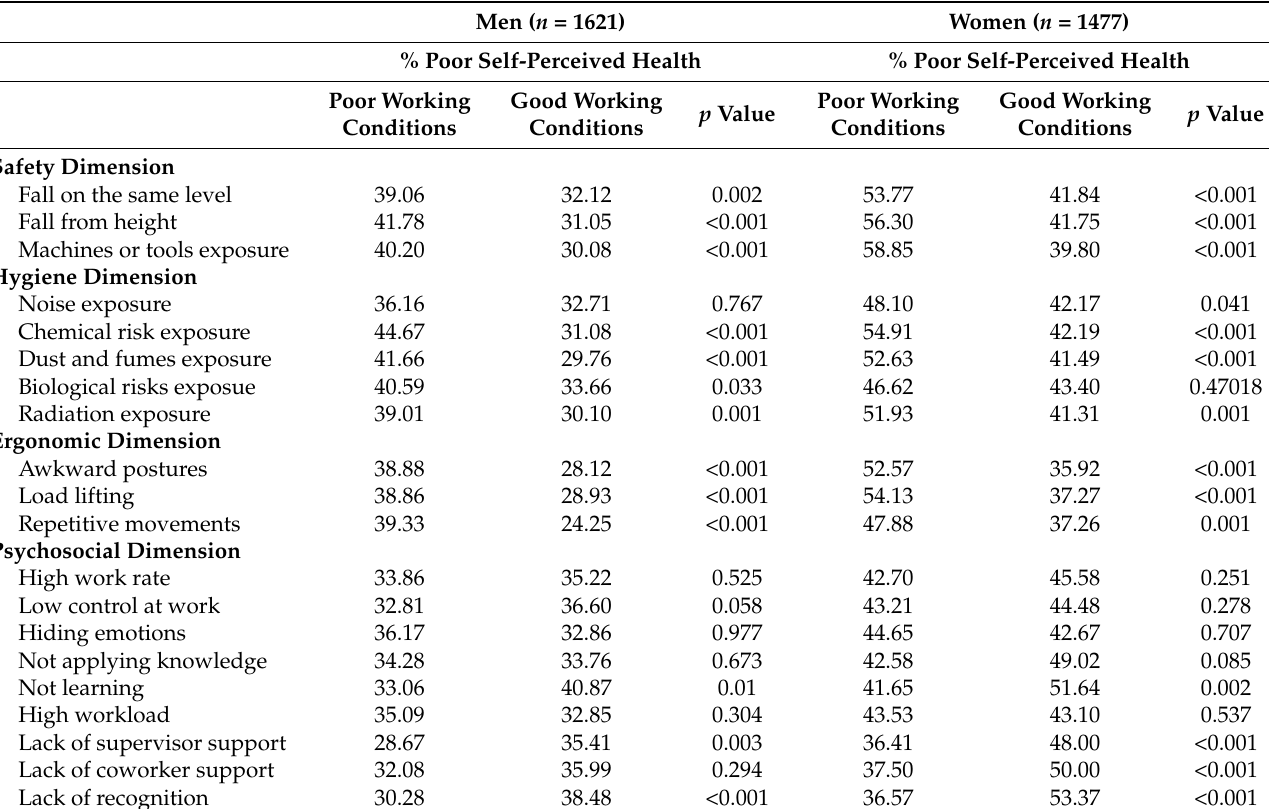
Table 2. Prevalence of poor self-perceived health according to working conditions by sex, working conditions survey of Peru 2017. Men ( n =